Question: What type of chart is this?
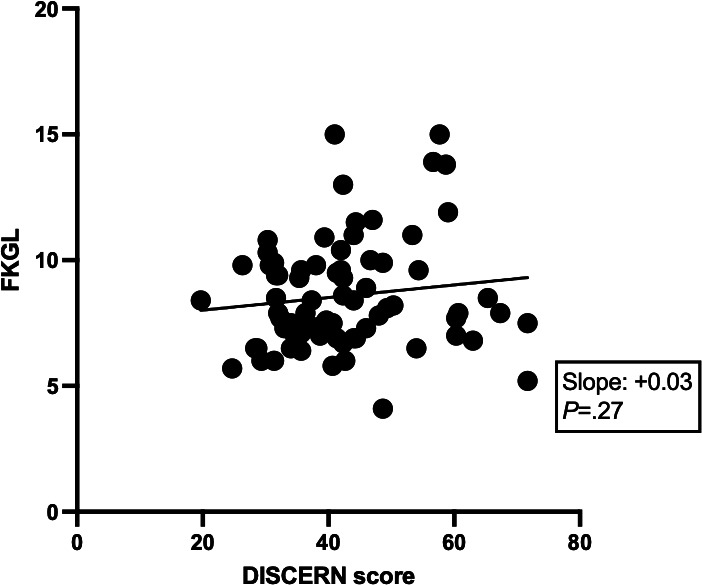
Answer: scatter